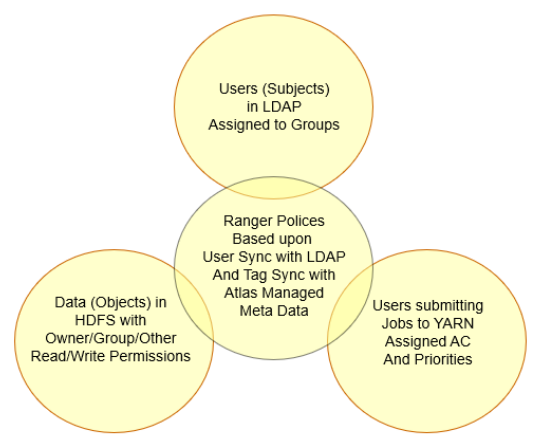
Figure 11. Implementation of ABAC using the HDFS, LDAP, YARN, Ranger, and Atlas.